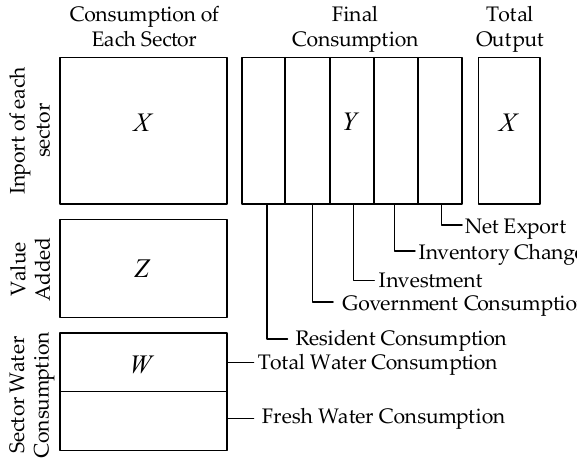
Table A2. Names and classifications of the 51 sectors. Non-water Conservancy Sectors